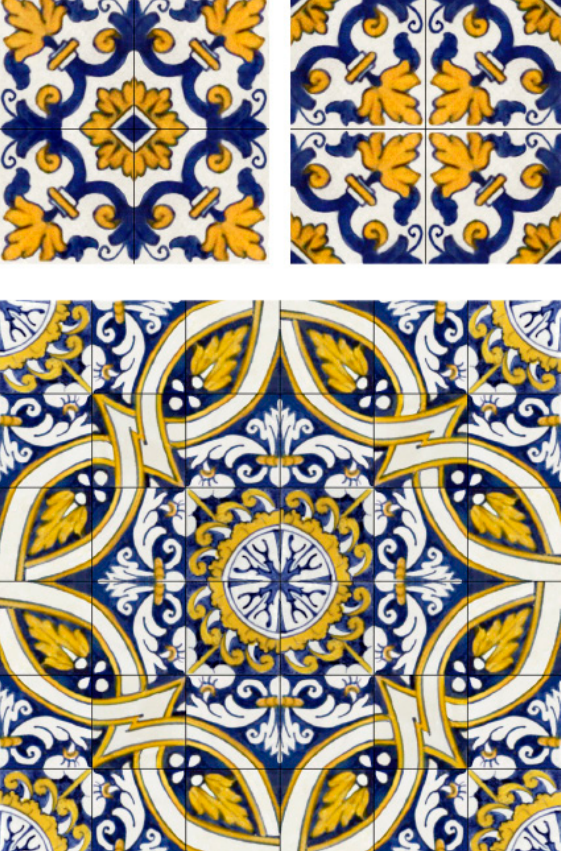
FIGURE 8 | Pattern P-17-00311 with 2x2 tiles used on the arches of the vaults in the lower-choir and pattern P-17- 00602 with 6x6 tiles used on the